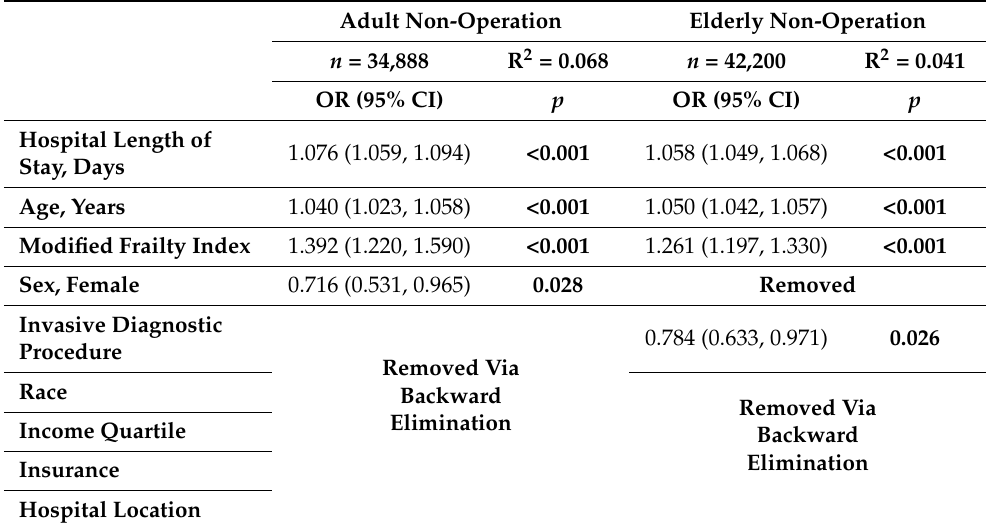
Table 6. Backward multivariable logistic regression analysis to evaluate the associations between mortality and different factors in emergency-admitted patients with the primary diagnosis of paralytic ileus and not undergoing an operation (NIS 2005–2014). Mortality was the dependent